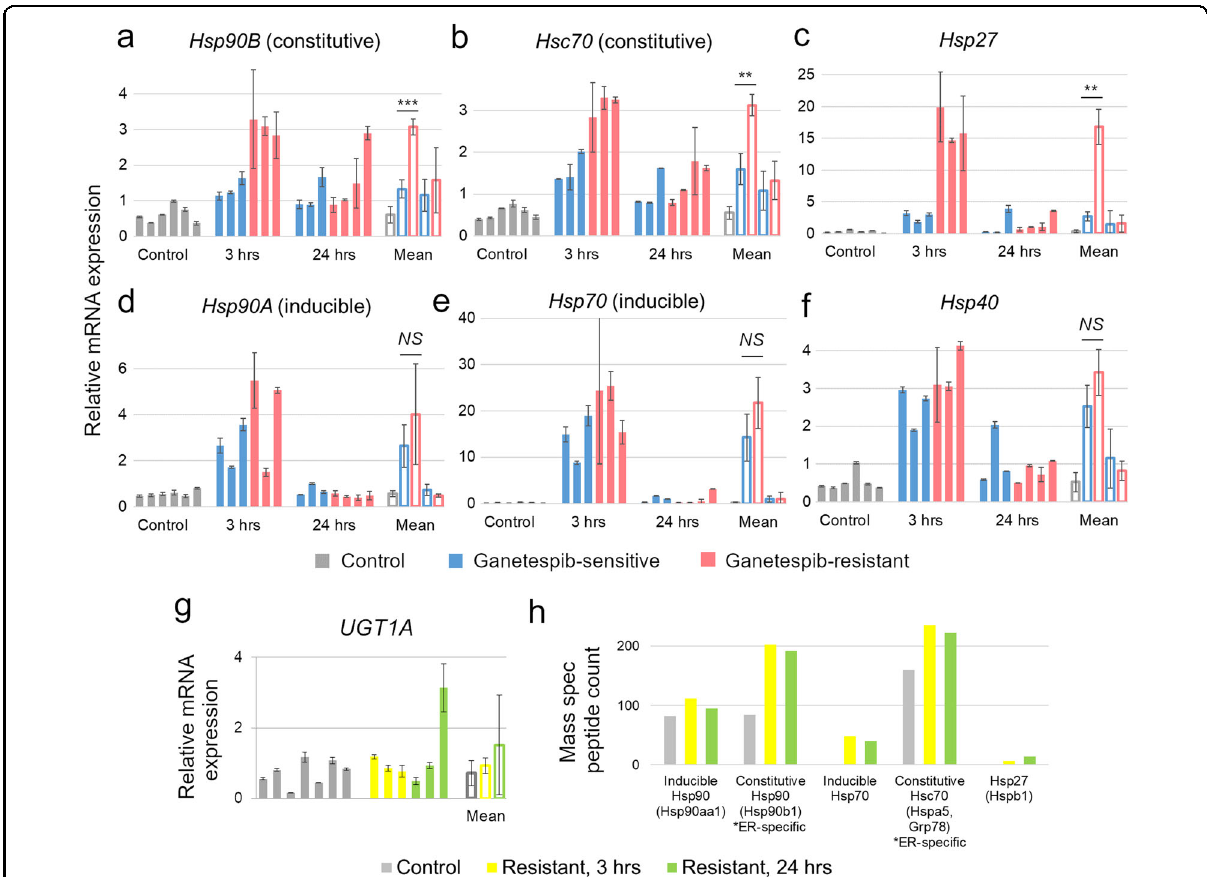
Fig. 2 Upregulation of compensatory heat shock proteins (HSPs) in Ganetespib-resistant Neu tumors. a – f All analyzed HSPs are upregulated in Ganetespib-resistant and Ganetespib-sensitive tumors at 3 h after the last Ganetespib dose and decline at 24 h. However, constitutive Hsp90B , Hsc70 and inducible Hsp27 ( a – c ), but not inducible Hsp90A , Hsp70 and co-chaperone Hsp40 ( d – f ), are signi fi cantly more upregulated at 3 h in Ganetespib-resistant tumors, that had received Ganetespib for over two months, compared with Ganetespib-sensitive tumors, that received Ganetespib only once. g UGT1A , previously implicated in primary — not acquired — Ganetespib resistance in colorectal cancer, is not upregulated in Ganetespib-resistant Neu tumors. a – g Quantitative RT-PCR. mRNA levels were normalized to HPRT . Mean ± SD of at least three biological replicas ( empty bars ) and two technical replicas ( solid bars ) are shown. ** p < 0.01, *** p < 0.001, NS , not signi fi cant; unpaired two-tailed Student ’ s t -test on the biological replicas. h Protein expression of the indicated HSPs at the indicated timepoints by mass spectrometry. Note that all HSPs are upregulated at both, 3 h and 24 h